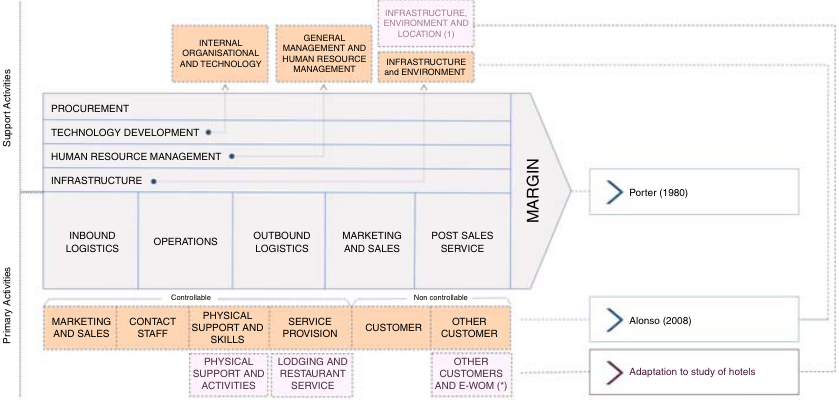
Figure 1. Adaptation of the value chain to the hotel